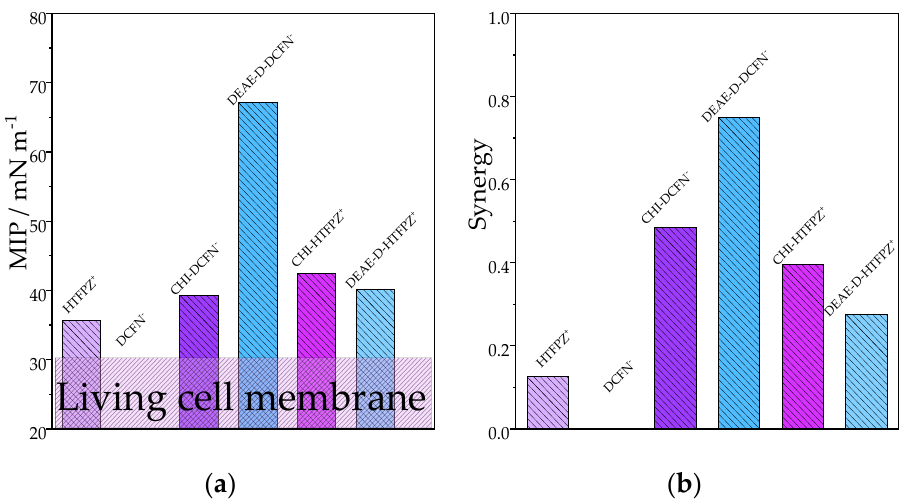
Figure 6. ( a ) Maximum insertion pressure (MIP) and ( b ) synergy values obtained for the different MNPs:drug mixtures with DSPA membrane.